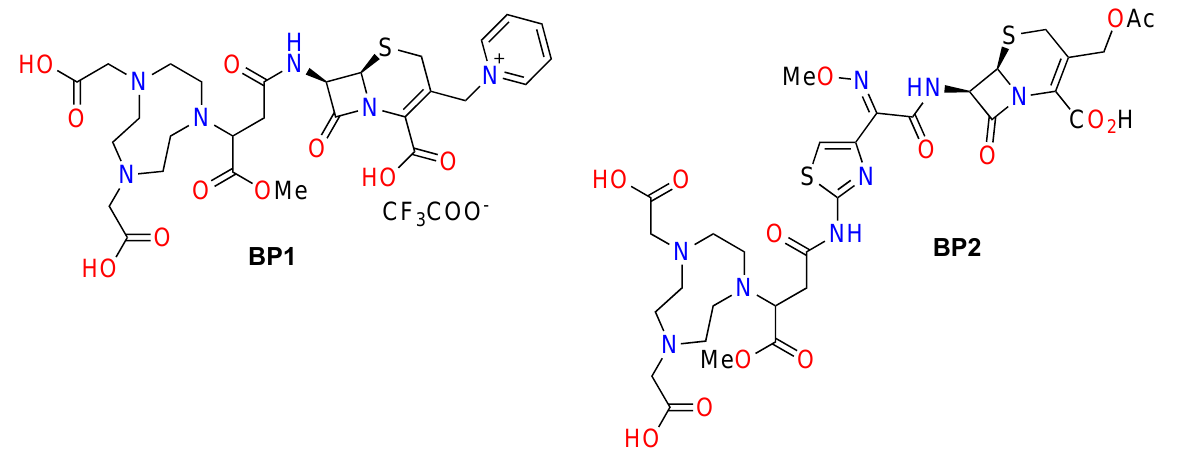
Figure 1. Molecular structure of cyclic amino acidic zinc chelators attached to antibiotic cores.